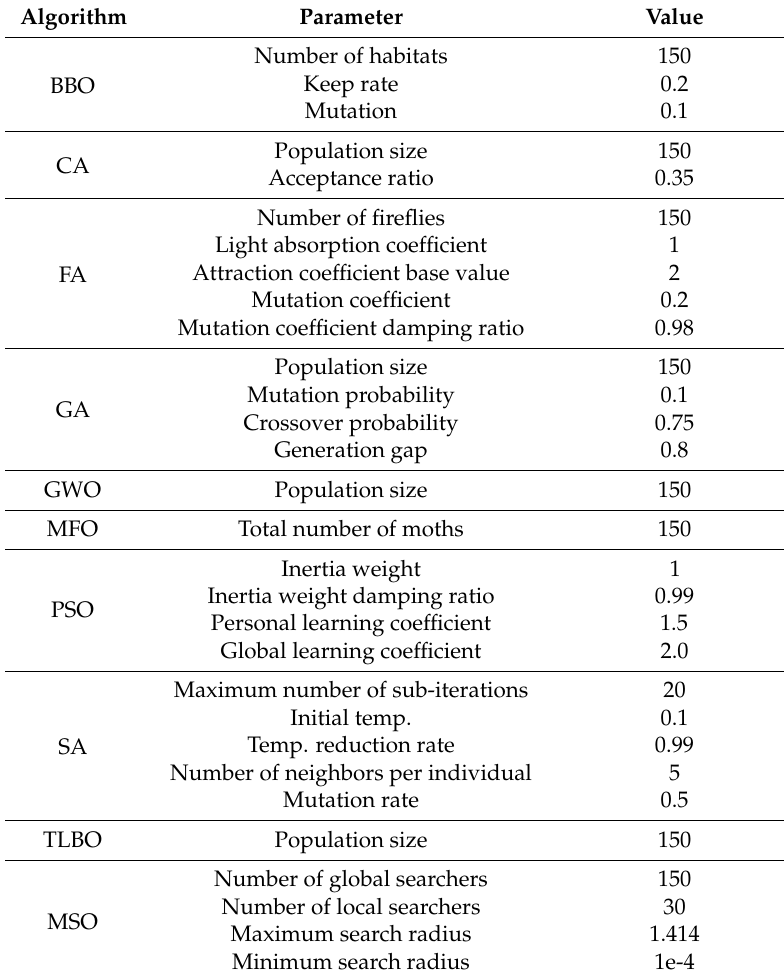
Table 1. Summary of the most important parameters used for different